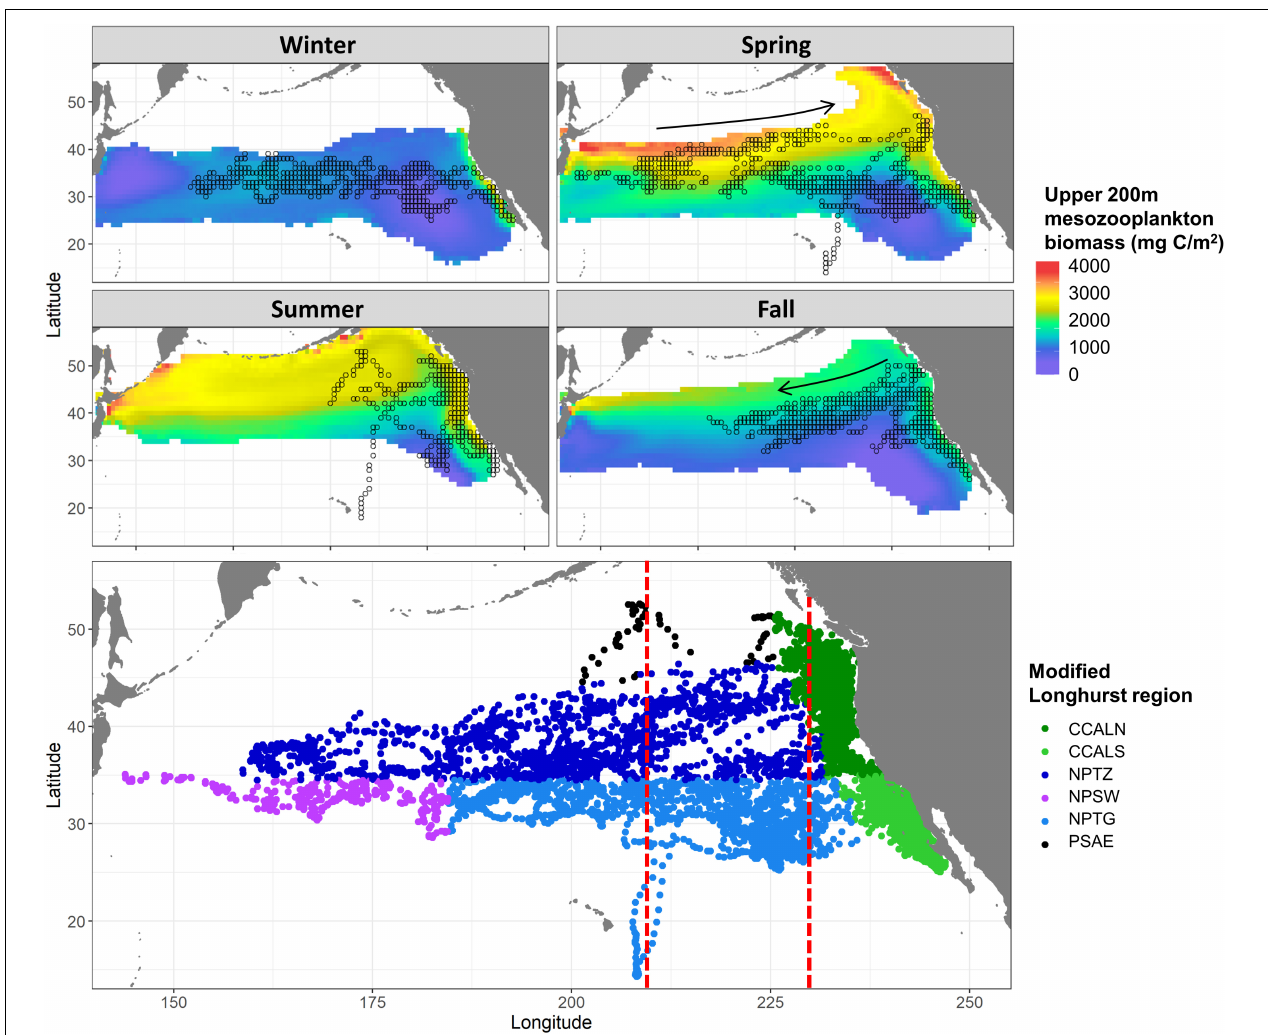
FIGURE 1 | Estimated daily positions for 33 tagged albacore from 2003 to 2013. Top: positions shown by quarter at 1 × 1 resolution, overlaid on 2000 – 2017 climatological integrated upper 200 m mesozooplankton biomass (Park et al., 2018). Locations where SST from the Park et al. (2018) model is outside the range of 12–22 ◦ C (which contains > 99% of tag locations) are masked. Arrows denote typical directions of migrating fish. Bottom: positions shown by modified Longhurst region (Longhurst, 2007): The Coastal California Current province was split into north (“CCALN”), and south (“CCALS”) of 35 ◦ N, “NPTZ” is North Pacific Transition Zone (also known as North Pacific Polar Front), “NPSW” is North Pacific Subtropical Gyre Province (West), “NPTG” is North Pacific Subtropical Gyre, and “PSAE” is Pacific Subarctic Gyres Province (East). Twenty points in the Alaska Coastal Downwelling province were also assigned to CCALN, and 16 points in the Kuroshio Current province were assigned to NPSW. The Bering Sea and Sea of Okhotsk are masked, as albacore are not known to occur in these areas. The vertical red lines denote 210 ◦ E and 230 ◦ E: the cutoffs between “Long-migratory,” “Short-migratory,” and “Resident” fish (see Table 1